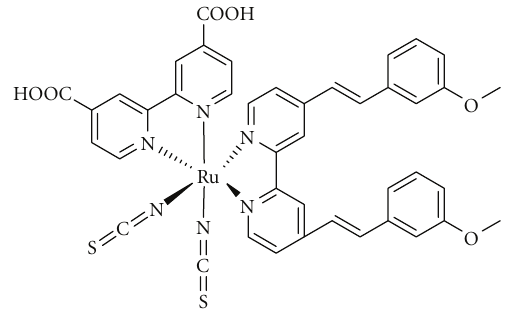
Figure 5: Molecular structure of Z910 (taken from